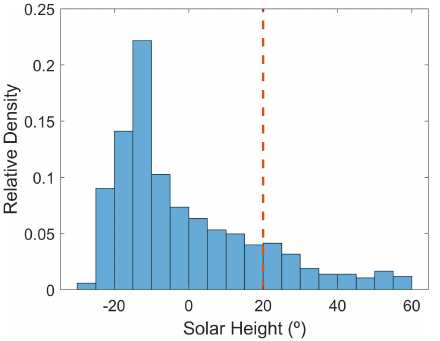
Figure 3. Histogram of the relative density of NLLJs by solar height. The dashed red line represents the selected maximum so- lar height for the definition of a “NLLJ night”.